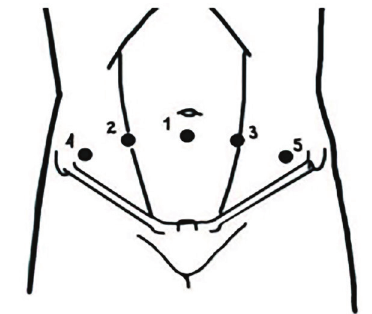
Figure 1 - The location of trocars during extraperitoneal laparoscopic prostatectomy: 1, 5 – trocars of 10mm, 2, 3, 4 – trocars of 5 mm.